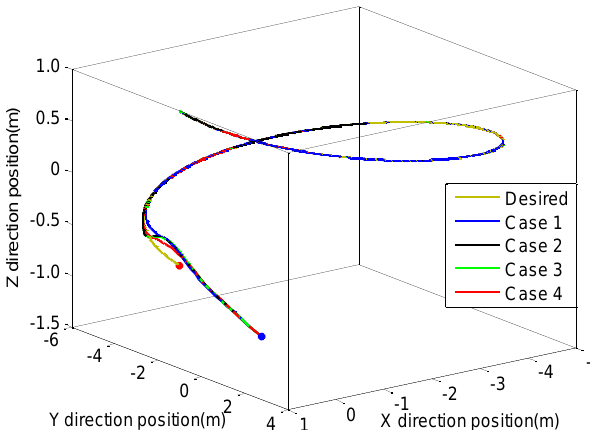
Figure 5. Trajectories (four cases).